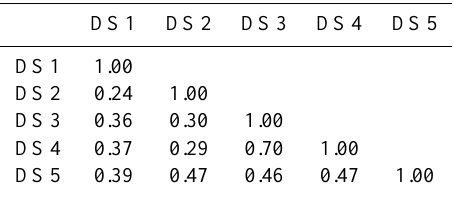
Table 6. Correlation matrix of the linear correlation coefficients ( V Cramer) for the final five susceptibility maps, classified probabili- ties.